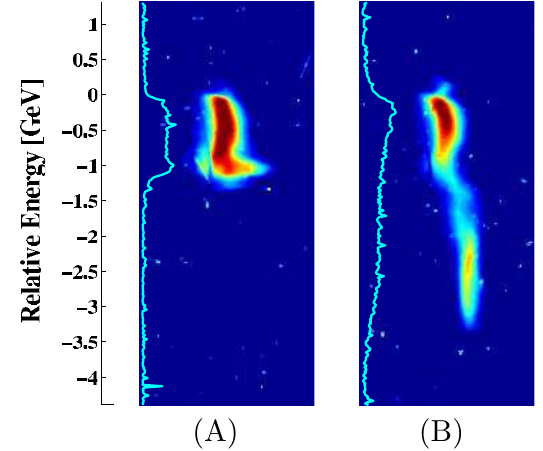
FIG. 9. (Color) Both images show the energy spectrum of the electron beam at the Cherenkov radiator. (A) The bunch is approximately 42 (cid:2) m long and no ionization has occurred in the NO gas. (B) The bunch is approximately 26 (cid:2) m long and ionizes the NO gas.